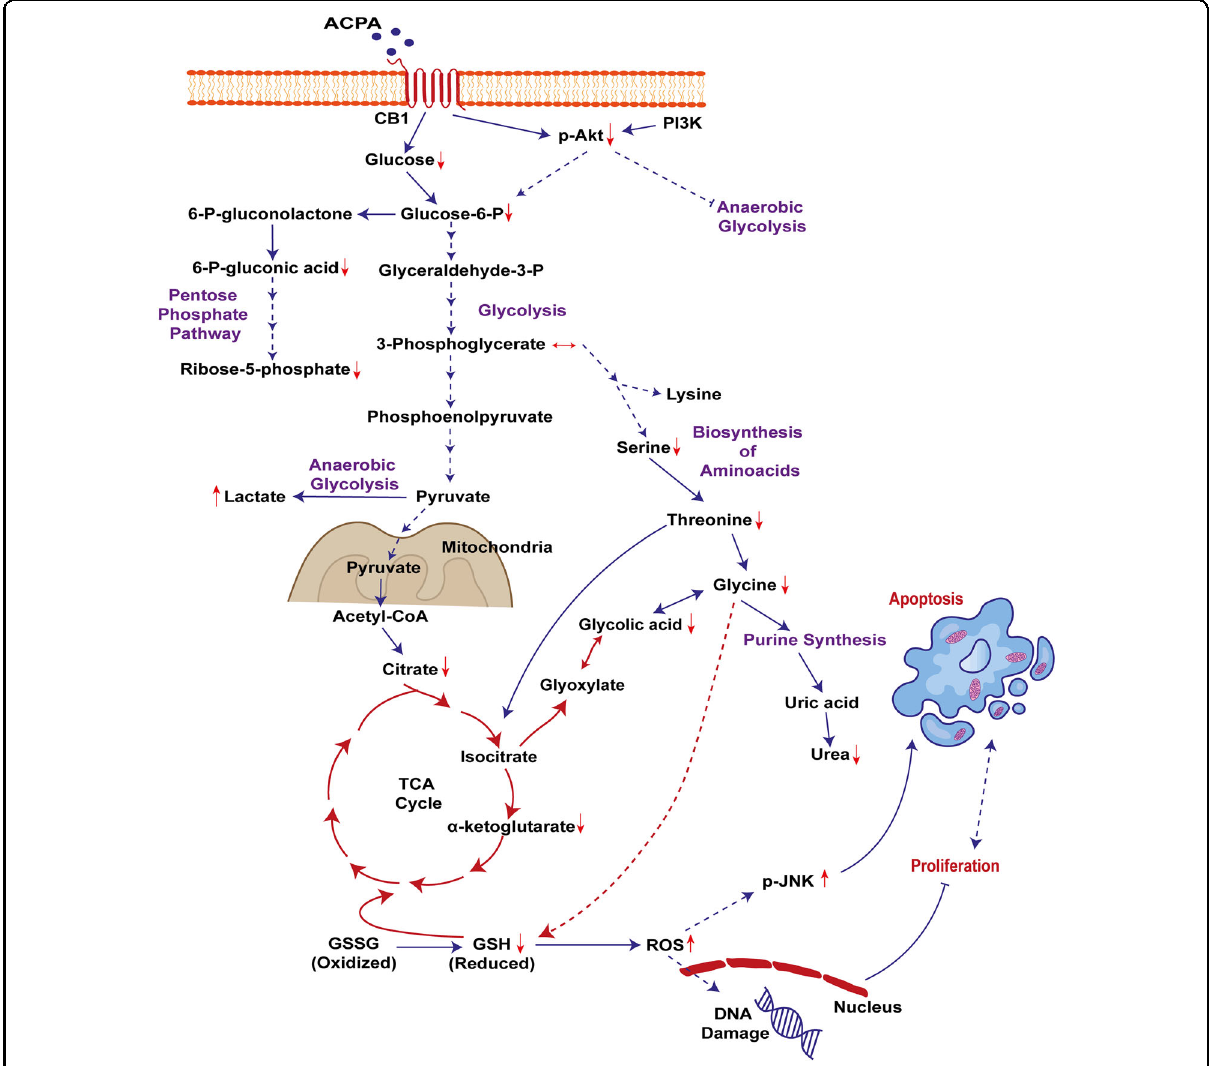
Fig. 5 ACPA promotes Akt and JNK signaling pathways and affects several cellular processes in NSCLC lines. Critical metabolites in glycolysis, pentose phosphate, amino acid biosynthesis, and TCA cycle affected in A549, H1299, H358, and H838 cells on day 1 after IC50 dose of ACPA